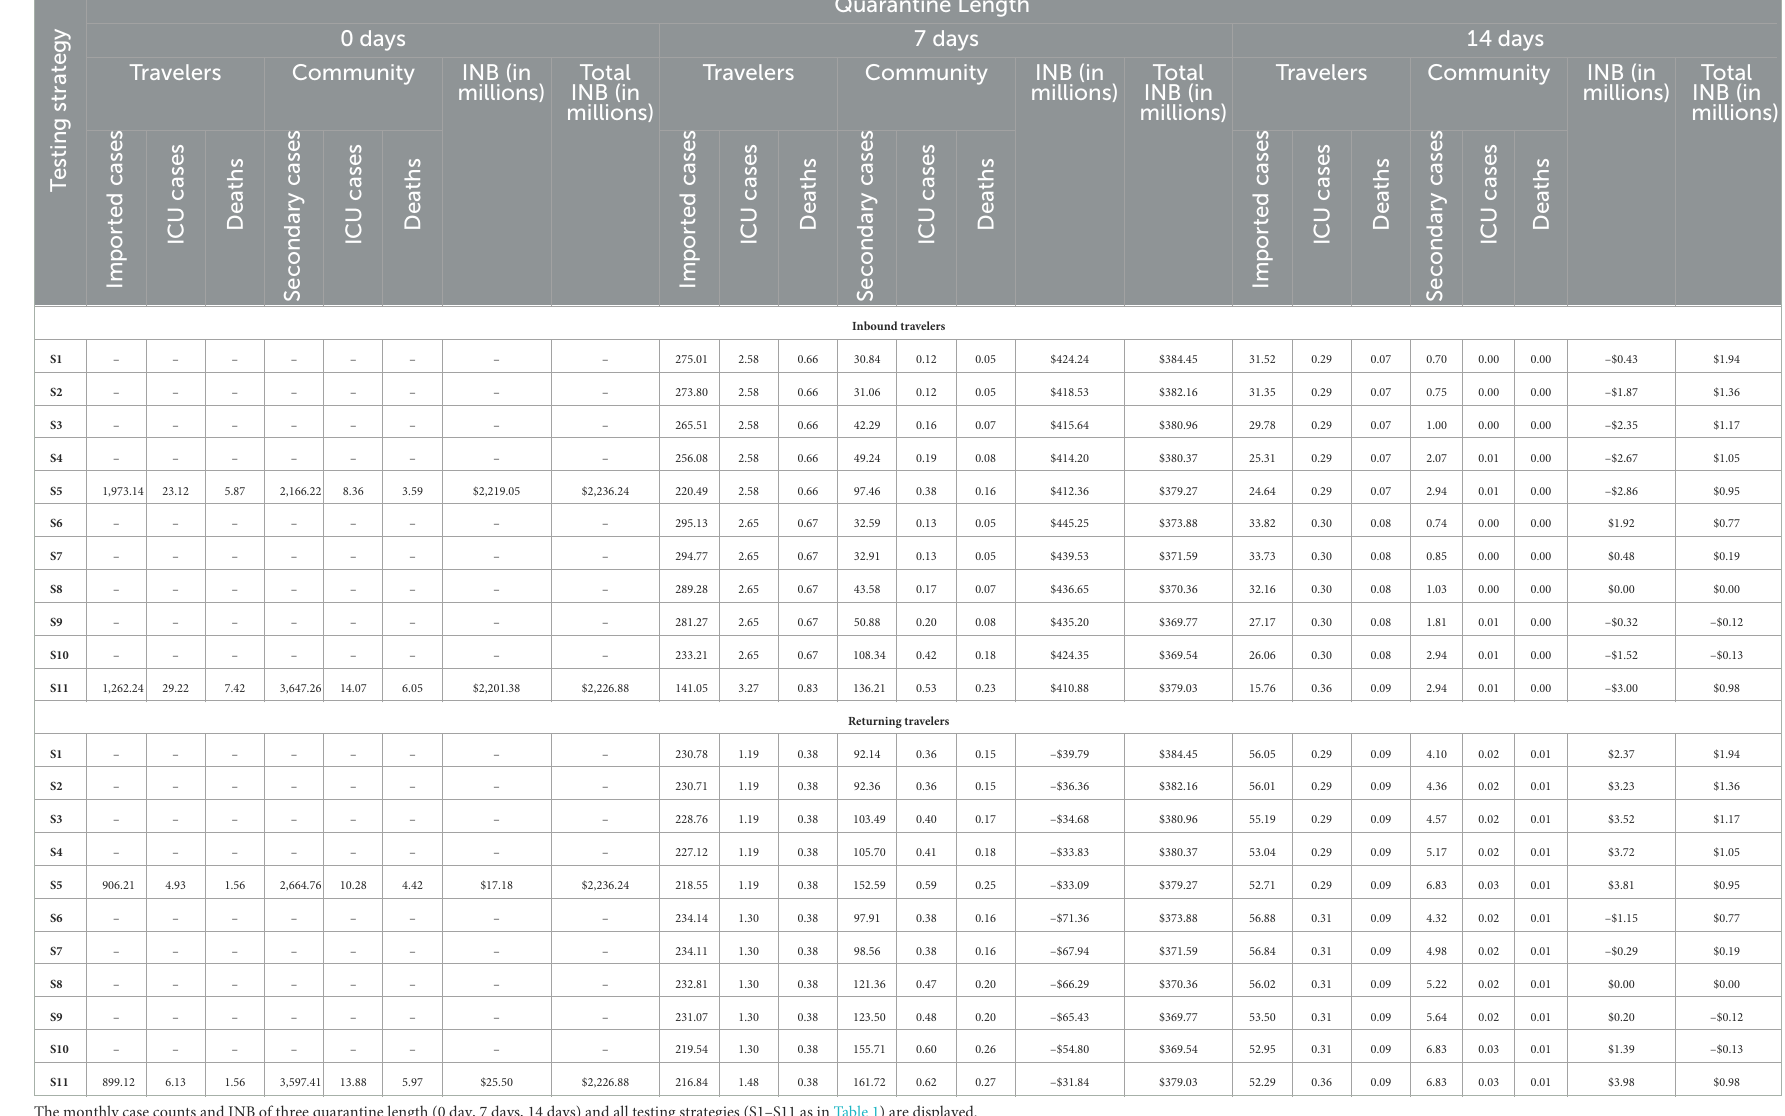
TABLE 3 Monthly COVID-19 case counts and INB from vaccinated and unvaccinated travelers under different